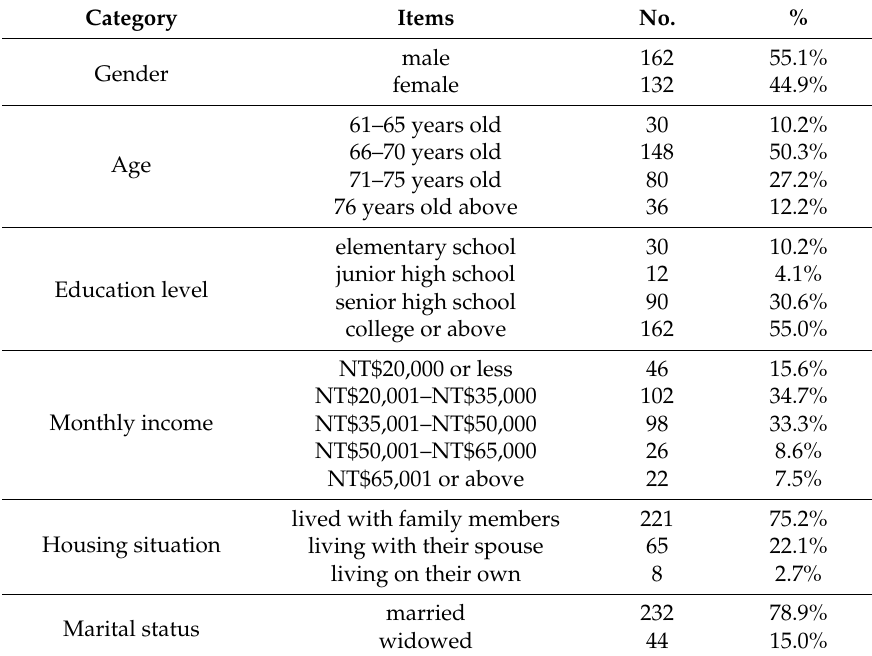
Table 1. Socio-demographic profile of the